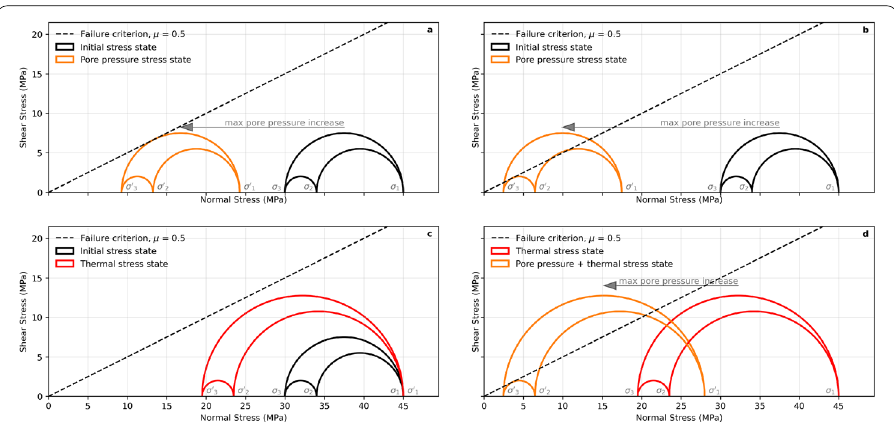
Fig. 3 Mohr circles for a friction coefficient of 0.5 (black dashed line) showing the initial stress state (black circle) and the effective stress state (orange circle) with the pore pressure increase required for a critically dipping fault along the σ 1 – σ 3 plane ( a ). Pore pressure increase required for a vertical fault to reach failure along the σ 2 – σ 3 plane ( b ) and effect of thermal stresses for a laterally confined reservoir where the thermal stress acts on the horizontal components of the stress tensor with a (cid:31) T of 49.2 K and rock properties according to Table 3 ( c ). Pore pressure increase required to reach failure along the σ 2 – σ 3 plane of a thermally stressed reservoir ( d